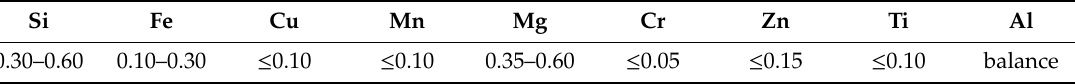
Table 1. Chemical composition (nominal) of Al6060-T66 [25].